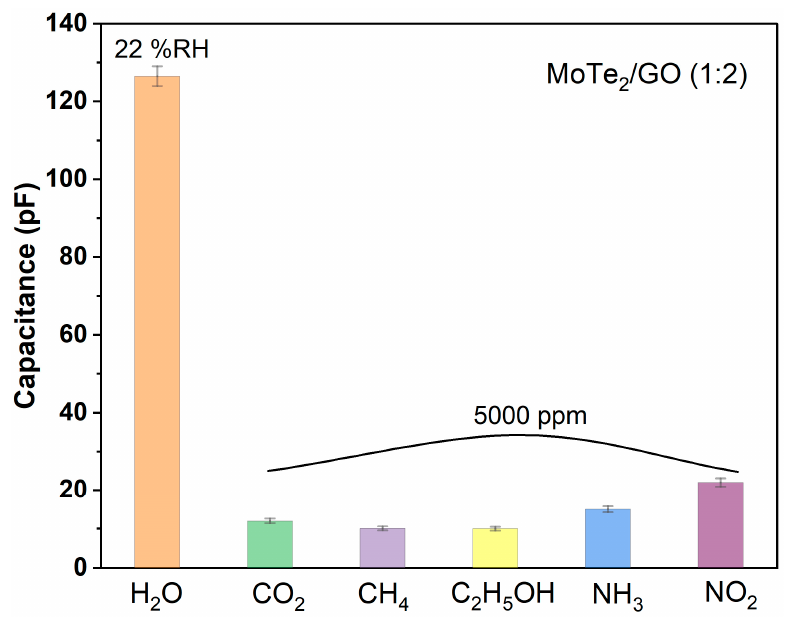
Figure 8. The capacitance of the proposed sensor to various gases.